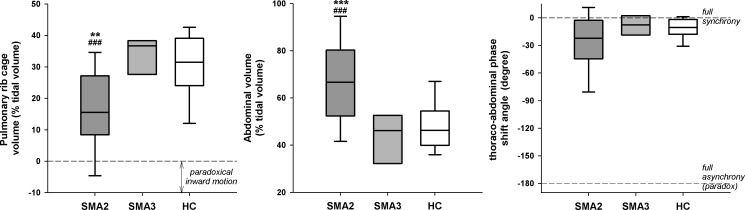
Box-and-whisker plot representing the median (line within the box), the IQR (length of the box), the 90th and the 10th percentiles (whiskers above and below the box) of pulmonary ribcage percentage contribution to tidal volume (left panel), abdominal percentage contribution to tidal volume (middle panel) and thoraco-abdominal phase shift angle (right panel) in SMA types II, III and healthy children (SMA2, SMA3 and HC, respectively) at rest during spontaneous quiet breathing in seated position.**,***: p<0.01, 0.001 vs SMA3; ###: p<0.001 vs HC